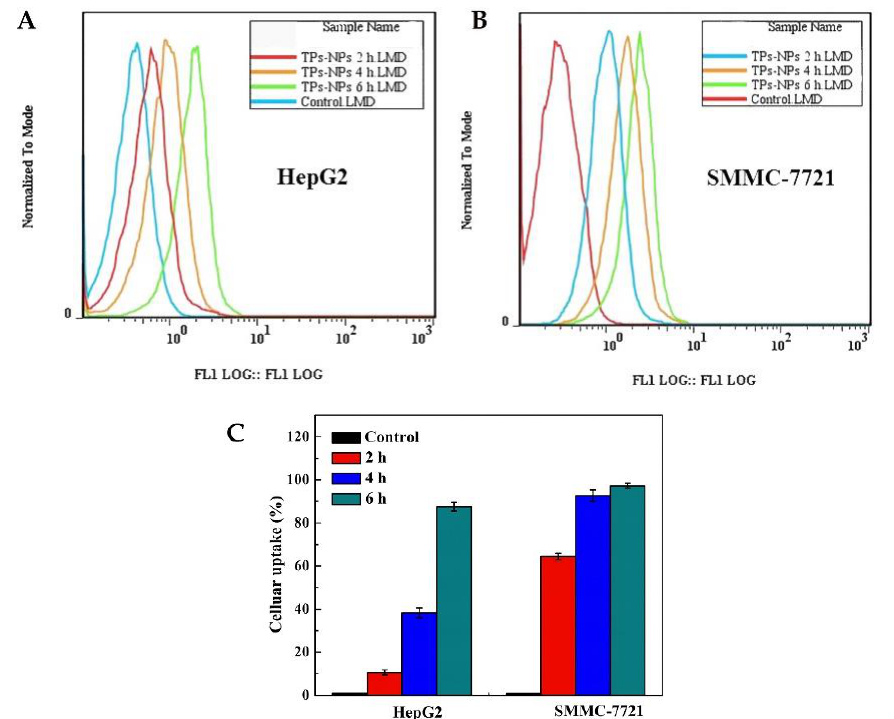
Figure 3. Cellular uptake of fluorescence-labeled NPs. (A) the migration curve of cellular uptake in HepG2 cell; (B) the migration curve of cellular uptake in SMMC-7721 cell; (C) Cellular uptake rate in two cell lines at 2, 4 and 6 h. Cellular uptake of FITC-TP 5 -NPs at 2, 4 and 6 h was determined by flow cytometry. Cellular uptake increased by 86.5% in HepG2 and 96.5% in SMMC-7721 cells within 6 h. Abbreviations: TPs-NPs, TPs-loaded nanoparticles.